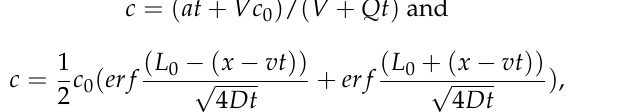
Figure 10. Change of lactate concentration in the fl ow process. ( A ) Change of lactate concentration during fl ow from point A to point B. ( B ) Change of lactate concentration during fl ow from point B to point C. ( C ) Comparison of the calculated results and the experimental data.